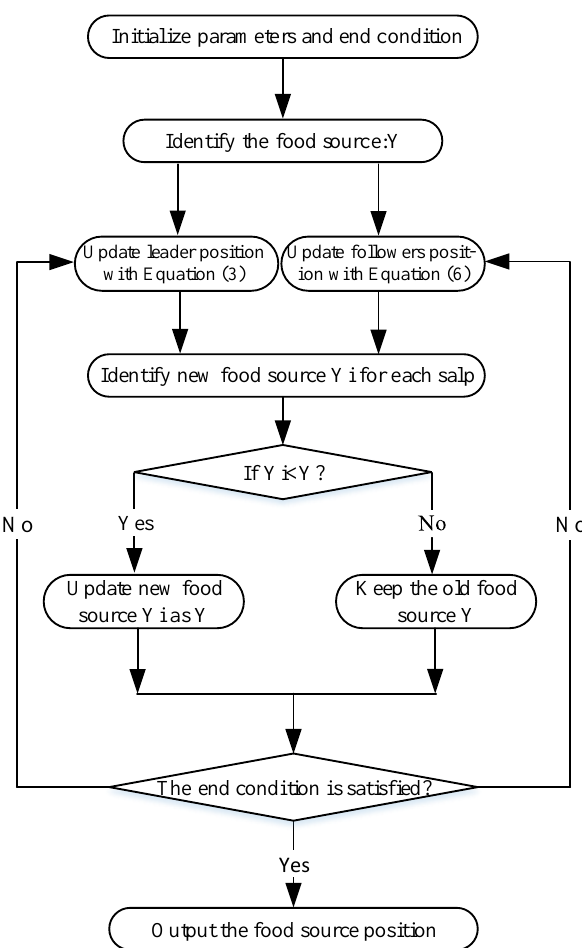
Figure 1. The flowchart of the salp swarm algorithm